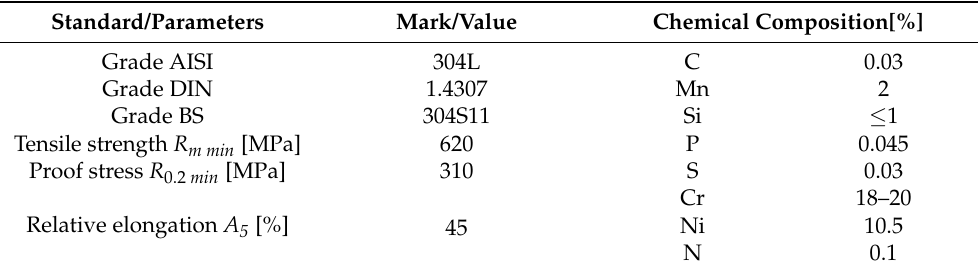
Table 3. Designation, parameters, and chemical composition of 304L stainless steel